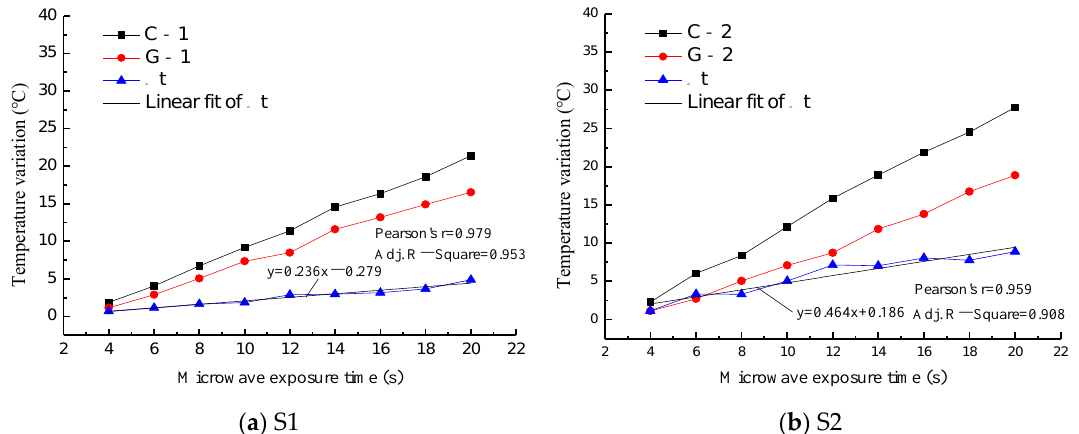
Figure 19. Results of coal and gangue microwave irradiation test under size S1 and S2.